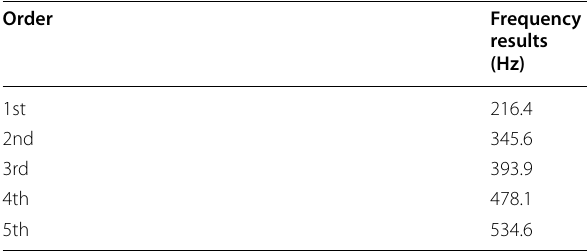
Table 3 Frequency result of the multi‑support pipeline